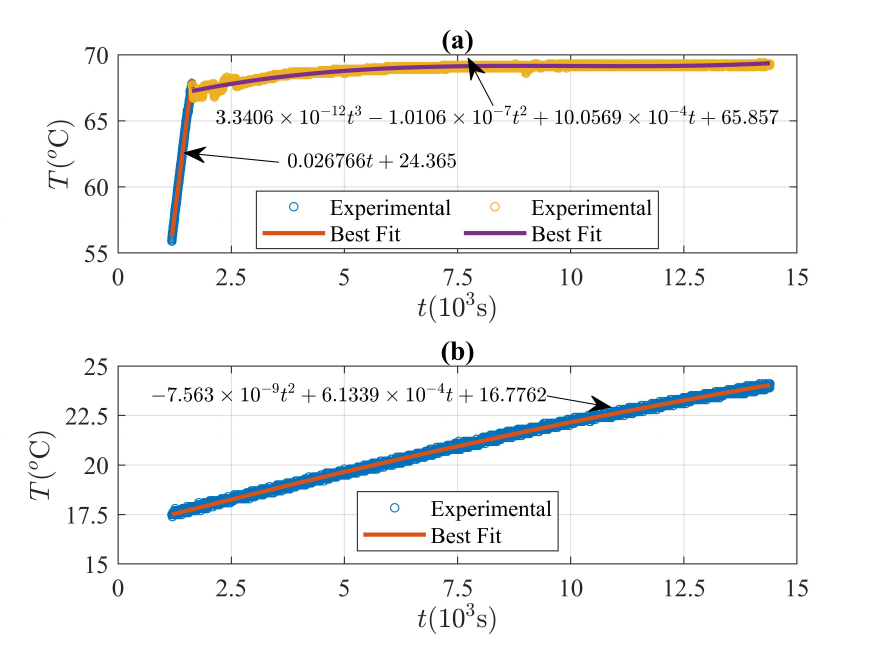
Figure 6. Nonhomogeneous isothermal boundary conditions. ( a ) Symbols represent time-dependent temperature values registered by the thermocouple located at the copper–PCM interface and the solid line corresponds to the best fit with the highest correlation. ( b ) Time-dependent temperature readings at the aluminium–PCM interface. Symbols represent the temperature values registered by the thermocouples located at r = 0.108m and the solid line is the best fit with the highest